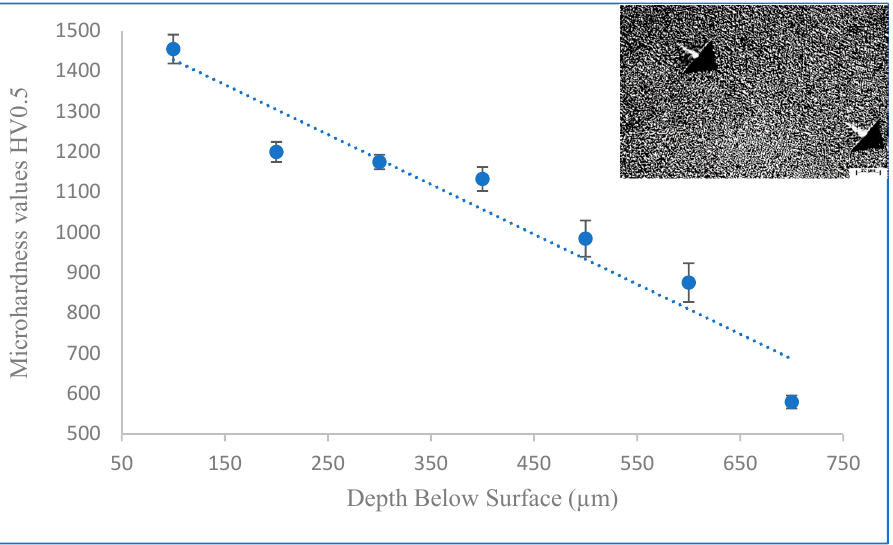
Figure 13. Microhardness distribution through S1-1–3 sample from the hardened layer towards as-cast zone. Error bars represent standard deviation.